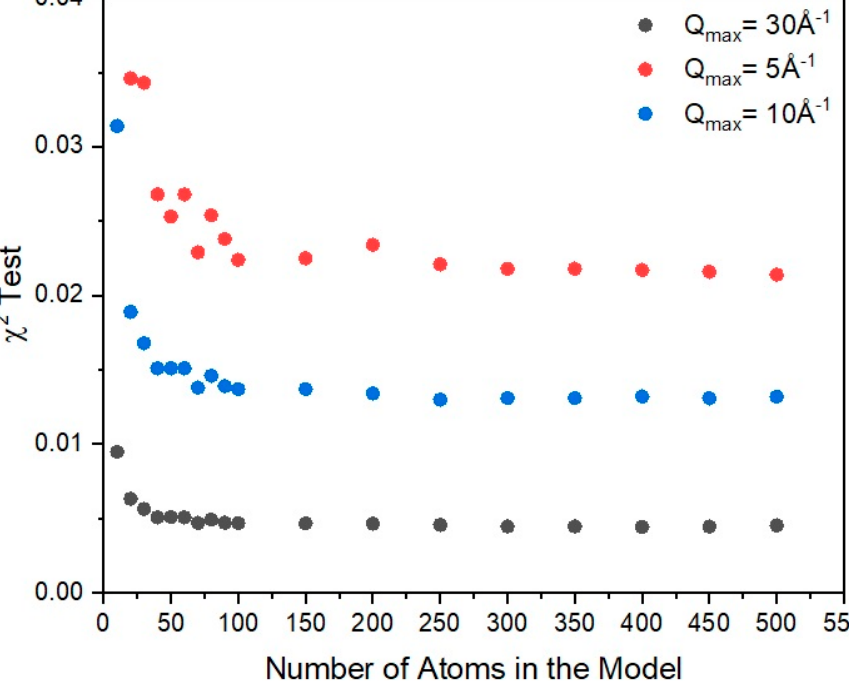
Figure 12. Comparison between the different χ 2 test results for a model of selenium based on the disordered helix as a function of chain length (indicated by the number of atoms in the model) and the different areas of the experimentally observed structure factor. Q max = 30 Å − 1 indicates the use of the entire scattering curve, Q max = 5 Å − 1 indicates the use of the first peak of the scattering curve and Q max = 10 Å − 1 indicates the use of the first two peaks of the scattering curve. In all cases, we can see that the statistical test becomes invariant for a model of at least 100 selenium atoms.